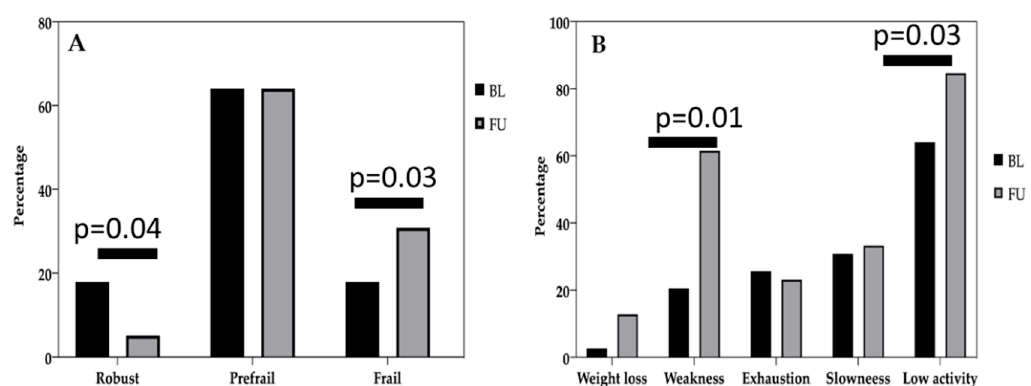
Figure 1. Evaluation of frailty syndrome in the study sample. Frailty was measured according to the 5 criteria proposed by Fried et al. [15]. ( A ) Percentage of the categories of frailty expressed as follows: participants who met 3 or more criteria were classified as frail, those who met 1 or 2 were prefrail, and those who did not meet any of the criteria were non-frail (robust). ( B ) Number of frailty criteria met in the sample, expressed as a percentage of the entire population. BL: Baseline; FU: Follow-up.